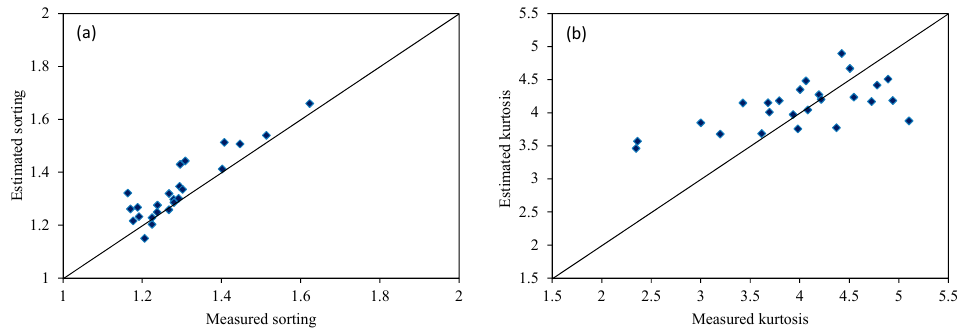
Figure 5. Comparison of the estimated sorting and kurtosis values of the suspended particles with the in situ measurements.